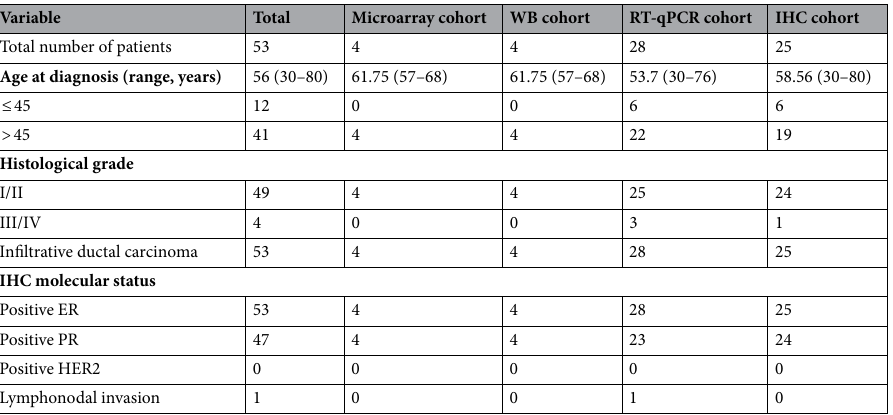
Table 1. Clinicopathological characteristics of the patients from all cohorts. IHC immunohistochemistry, ER estrogen receptor, PR progesterone receptor, HER2 human epidermal growth receptor 2, WB Western blot, RT-qPCR Real-time polymerase chain